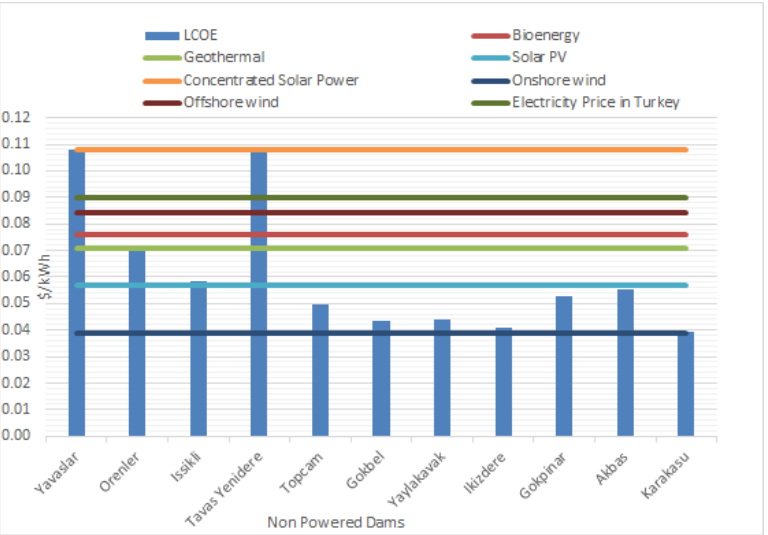
Figure 5. Levelized Cost of Electricity for Retrofitted